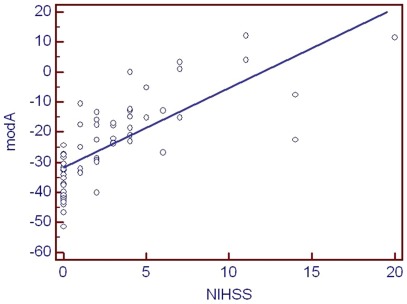
Scatter plot of National Institute of Health of Stroke Scale (NIHSS) score and the biomarker model classifier (modA).